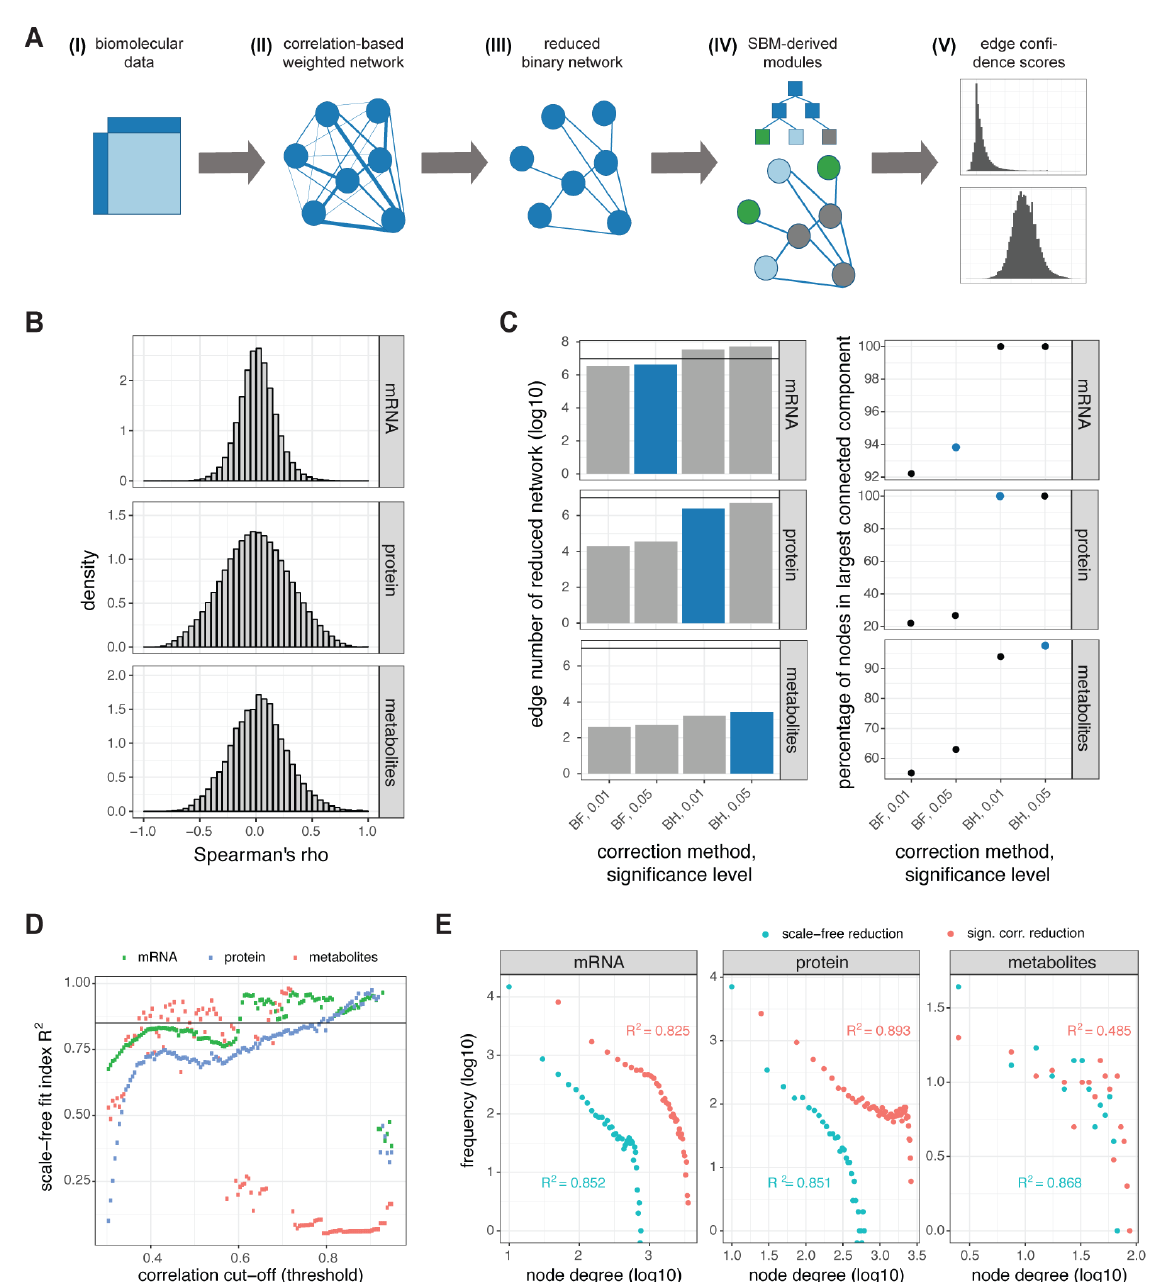
Figure 1. Analysis of correlation-based networks from different omics data: Pipeline and network preparation. ( A ) Pipeline for the approach. Given the matrix of measurements of mRNA expression, protein expression or metabolite abundance for a group of samples (I), we compute a fully-connected weighted network (II) of the molecular species for each data layer separately using a correlation- based approach. We reduce the networks by setting a threshold to the edge weights and binarize the networks (III). Each network is fitted to different types of stochastic block models in which the network nodes are partitioned into blocks (IV), the best fitting model is employed for deriving SBM-based edge confidence scores (V). ( B ) We established correlation-based networks using Spearman’s correlation within mRNA expression, protein expression and metabolite biomolecular data from a subgroup of cancer patients. Shown are histograms of the correlations obtained for all edges of the networks. ( C ) We only kept edges in the network that had a correlation which differed significantly from zero (sign. corr.). For different multiple testing correction methods (BH: Benjamini-Hochberg, BF: Bonferroni) and significance levels (0.05, 0.01), different degrees of reduction can be achieved. We chose for each data layer the most stringent threshold (highlighted in blue) that reduced the edge count to less than 10 7 edges (left) while keeping the percentage of nodes in the largest connected component high (right). ( D ) Scale-free fit indices R 2 according to 3 for the mRNA (green), protein (blue), and metabolite (red) network reduced by different correlation thresholds between 0.3 and 0.95. The employed threshold of 0.85 for the scale-free fit index is indicated by a black line. ( E ) Histogram of the node degrees of the networks reduced by criterion on significance of correlation (red) or on scale-freeness (blue) on double log-scale together with the scale-free fit indices R 2 . Networks are the more scale-free the more linear the relationship between log- frequency and log-node-degree is.